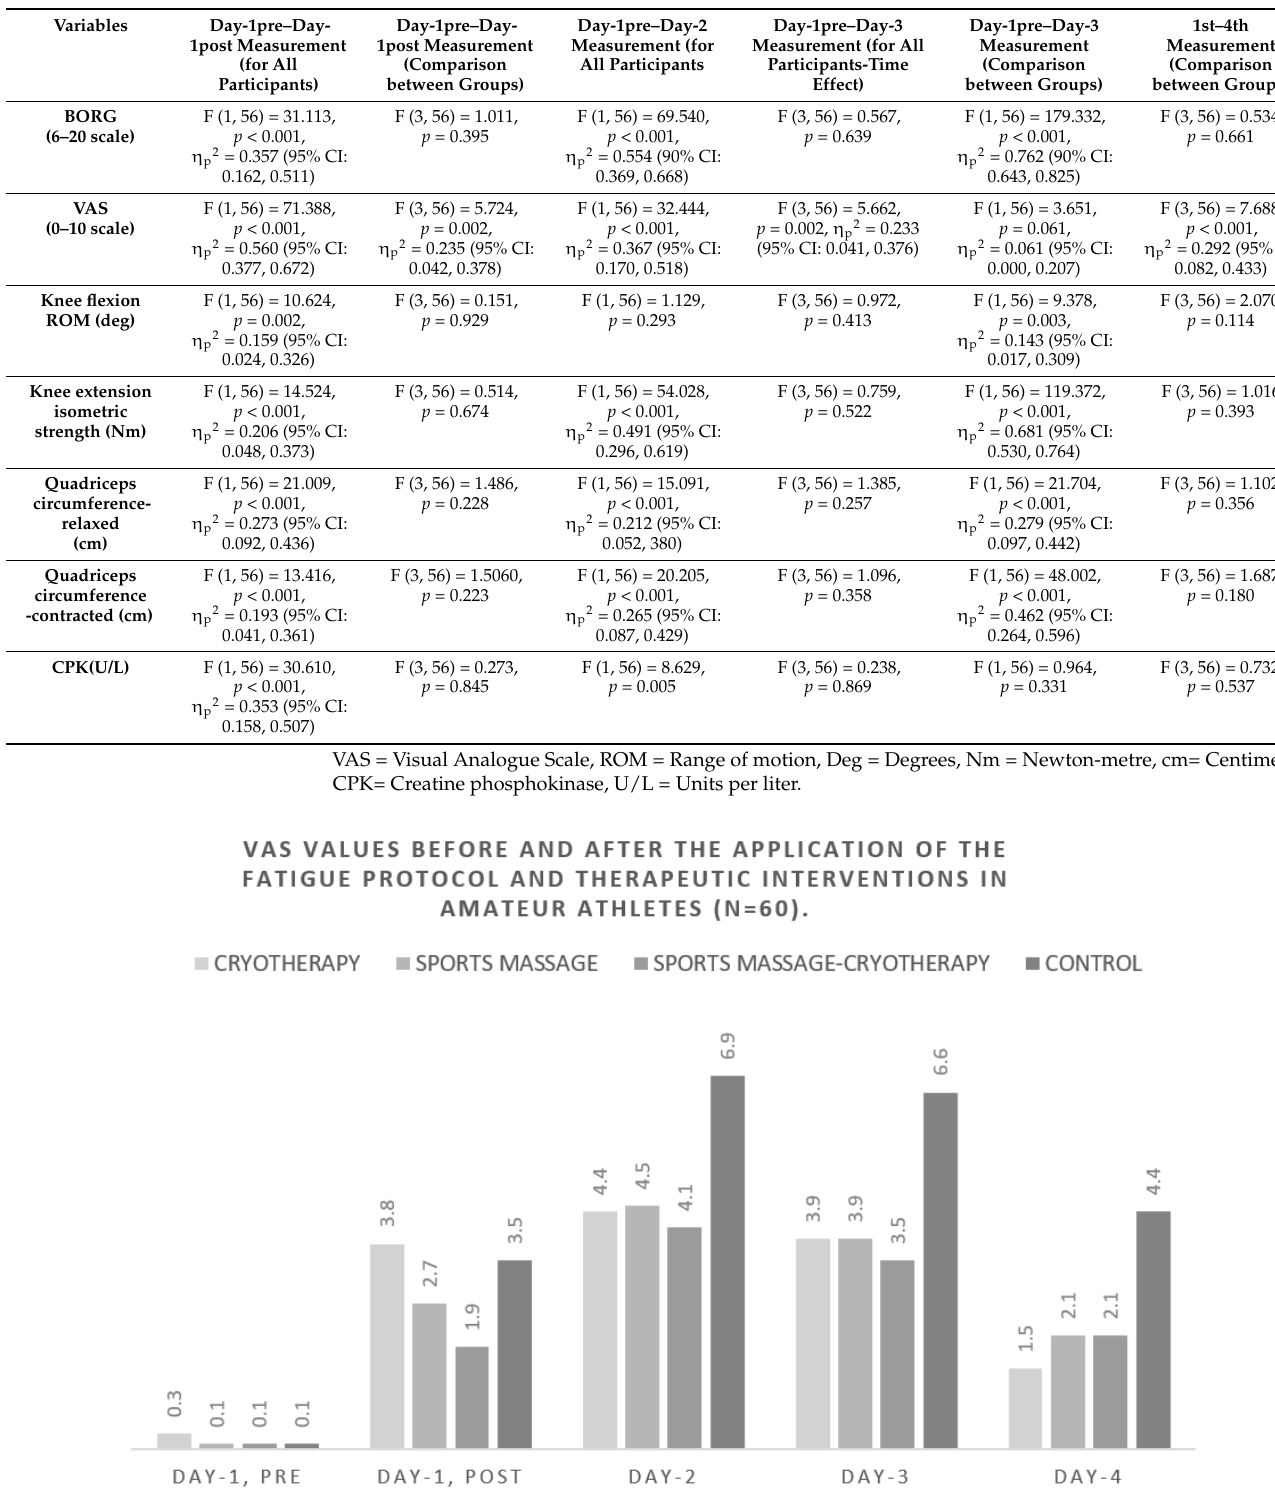
Figure 1. VAS values before and after the application of the fatigue protocol and therapeutic inter- ventions in amateur athletes ( n = 60).